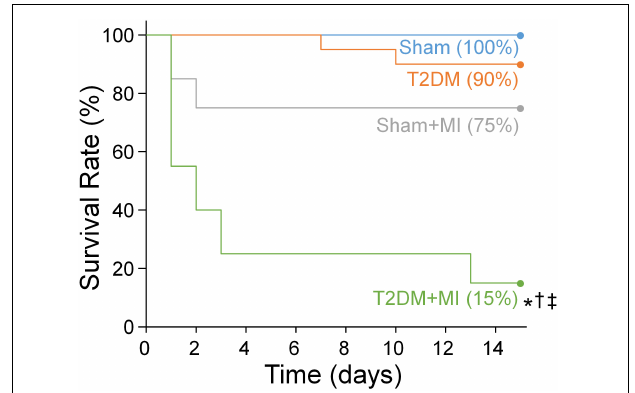
FIGURE 1 | The Kaplan-Meier analysis of survival rate within 2 weeks after MI in all experimental groups. There was no death occurred in sham rats and 90% of T2DM rats without MI survived during the 2-week observational period. The survival rate within 2 weeks after MI was significant lower in T2DM rats (15% in T2DM+MI), compared with sham rats (75% survival rate in sham+MI). n = 20 rats per group. Statistical significance was determined by Log-Rank test. * P < 0.05 vs. sham; † p < 0.05 vs. T2DM; ‡ p < 0.05 vs.